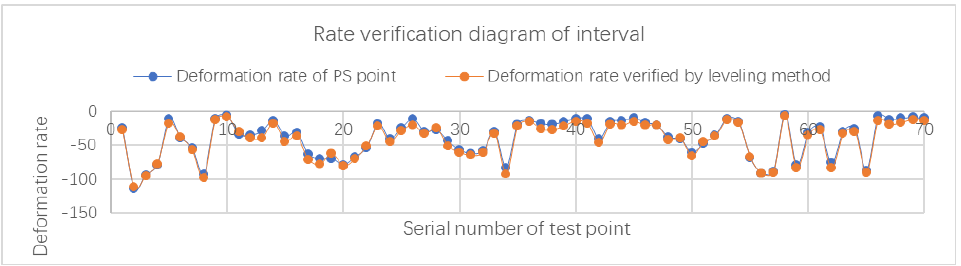
Fig.7 The Interval Rate